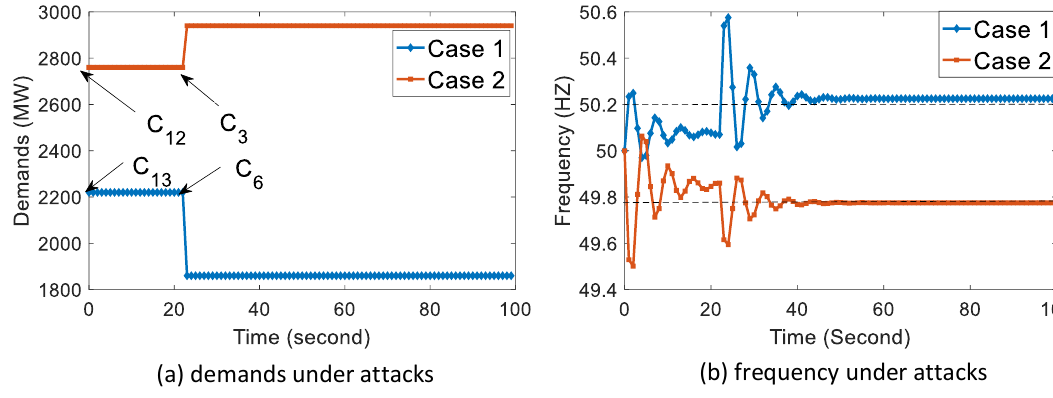
Figure 6. Real measurements under two attack